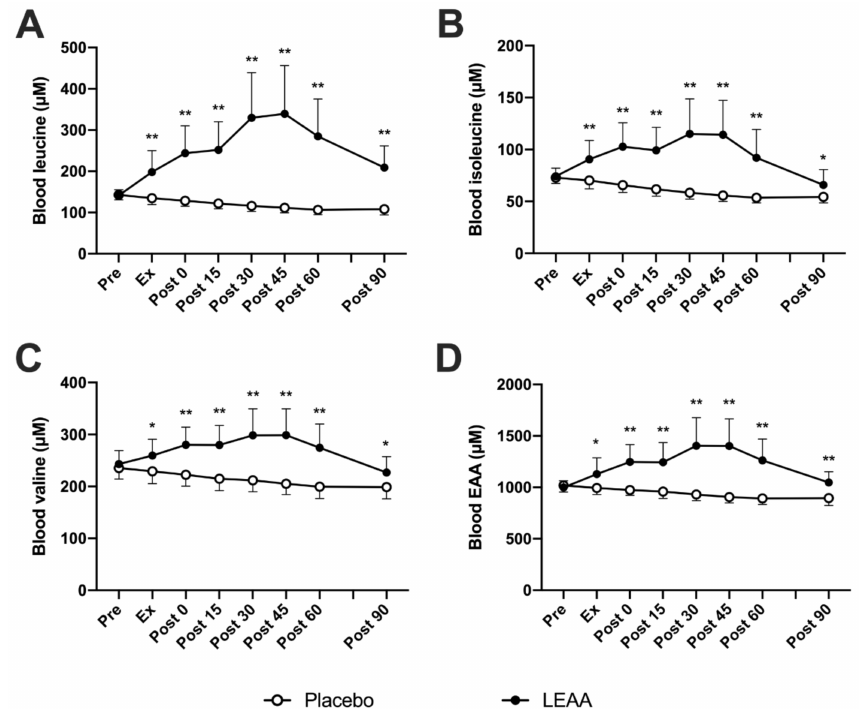
Figure 3. The e ff ect of LEAA supplementation on amino acid concentrations after a single bout of resistance exercise. ( A ) Leucine, ( B ) isoleucine, ( C ) valine and ( D ) the total EAAs. The data were analyzed using ANCOVA adjusted for baseline values. The data are expressed as the mean ± SD. * p < 0.05, ** p < 0.01 vs. placebo group at the same time